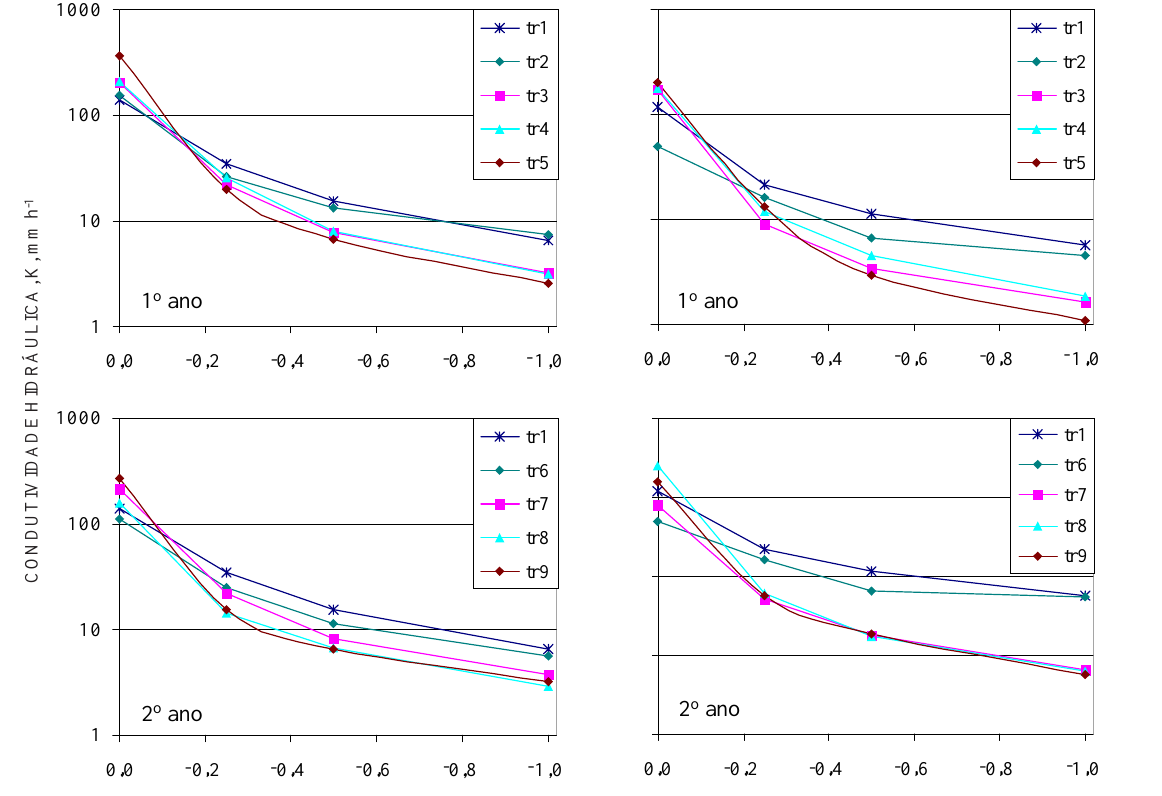
Figura 4. Valores médios de condutividade hidráulica (K), considerando o potencial mátrico, nos dois anos do experimento, para os tratamentos tr1, tr2, tr3, tr4 e tr5 (referentes à adubação mineral e às doses de lodo de esgoto) e tr1, tr6, tr7, tr8 e tr9 (referentes à adubação mineral e às doses de composto de